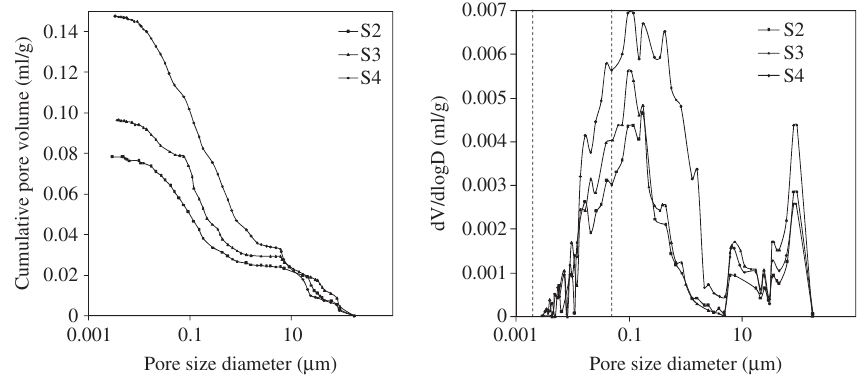
Figure 4 Pore-size distribution of artifically mixed soil samples measured by MIP.